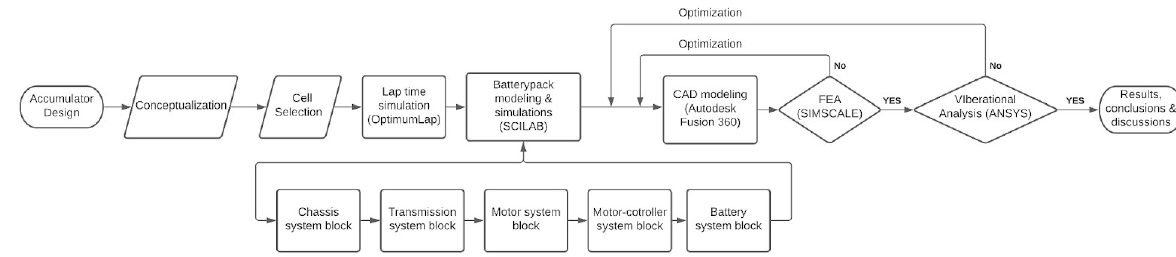
Figure 1. Methodology flowchart.